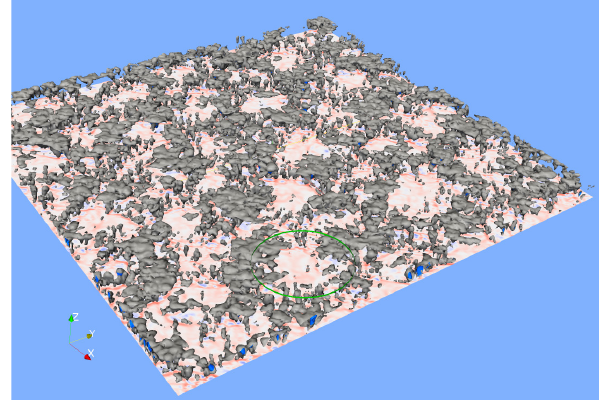
Fig. 5. DYCOMS-II: Cloud field visualisation after 9h for the N65 case, the green circle shows the dimension of one cloud cell and has a radius of 6.5km